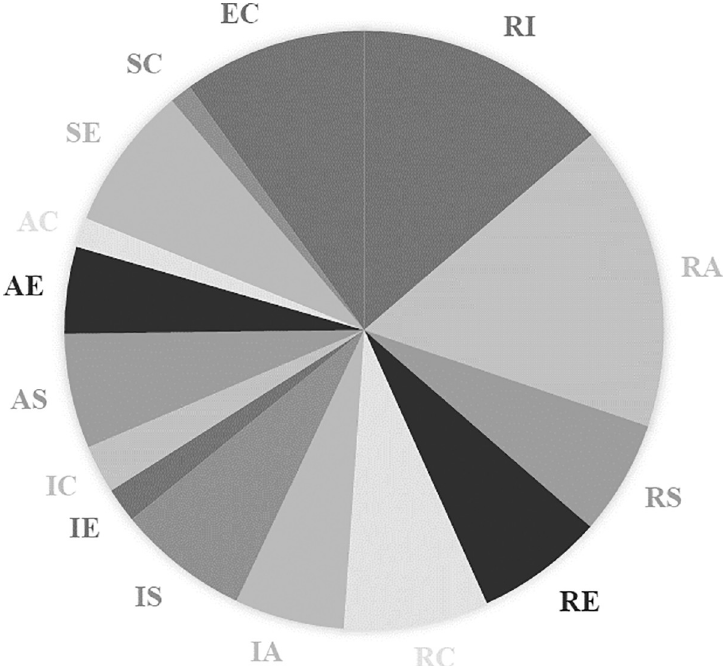
Fig 6. Distribution of two-dimensional interest types among young men. Note: The figure is also visually simplified by including one combination of letter orderings.